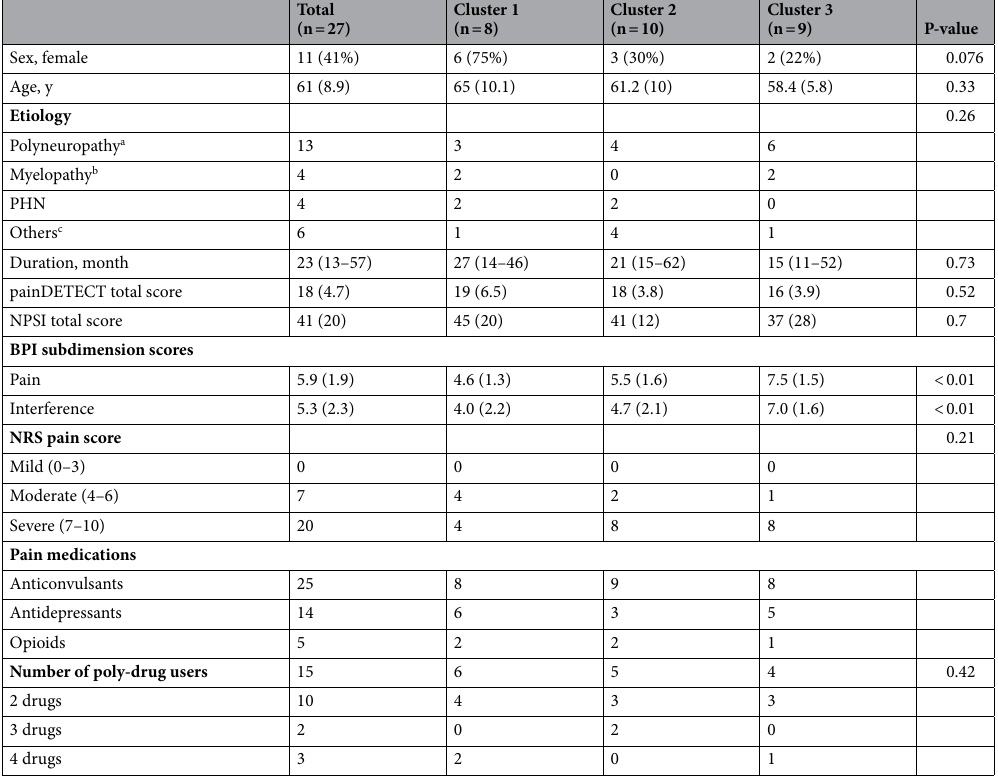
Table 1. Baseline characteristics. Data are expressed as number (%), mean (SD) and median (IQR) as appropriate. P-values are obtained using Fisher’s exact test for the categorical variables, and ANOVA for continuous variables. PHN, Postherpetic Neuralgia; NPSI, Neuropathic Pain Symptom Inventory; NRS, Numerical Rating Scale. a The causes of polyneuropathy include drugs (5 chemotherapeutic agents, 4 isoniazid, 1 linezolid), diabetes mellitus (1), Charcot-Marie-Tooth disease (1), and Guillain–Barre syndrome (1). b The causes of myelopathy include idiopathic transverse myelitis (2), spinal cord infarct (1), and cavernous hemangioma in spinal cord (1). c Others include spondylotic radiculopathy (2), traumatic nerve injury (2), brachial plexopathy (1 schwannoma), and subacute combined degeneration (1).